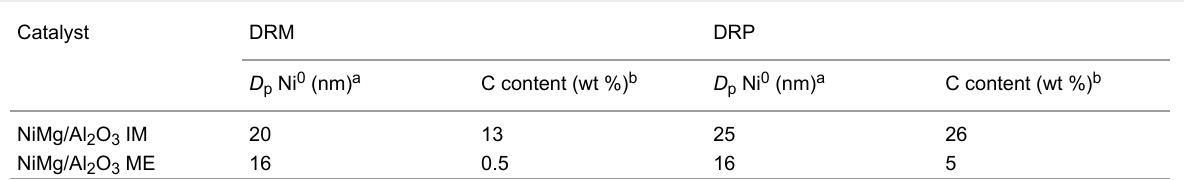
Table 4: The average particle diameter, D p , of Ni 0 and the carbon content in the catalysts after reaction [19]. ME = microemulsion method; IM = impregnation method. DRM = dry reforming of methane; DRP = dry reforming of propane.